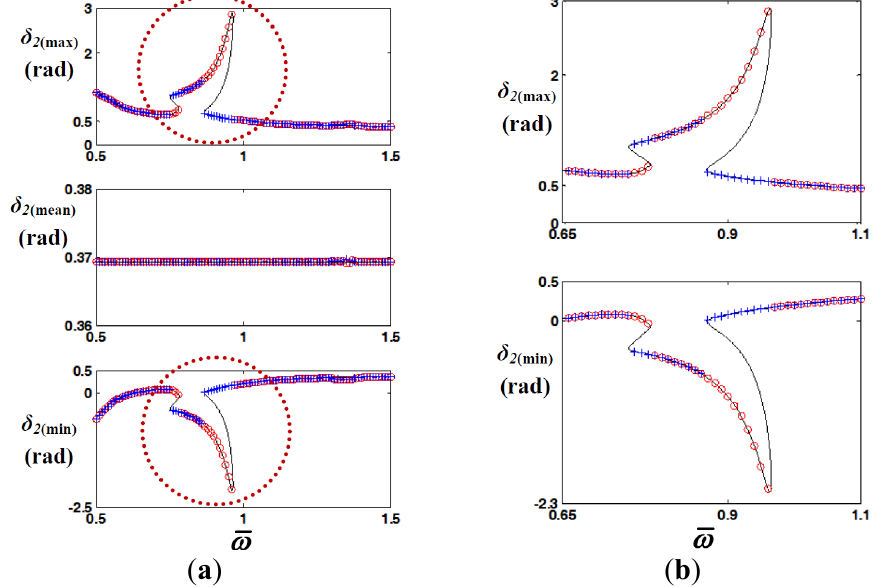
Figure 7. Comparison of HBM ( N max = 12 and ρ = 1) with NS in the frequency domain: t  ; and ( b ) illustration of jumping ( a ) comparison of max, mean, and min values of   2 phenomena under the frequency up- and down-sweeping conditions. Key: ━━ , HBM;  , NS by frequency up-sweeping;  , NS by frequency